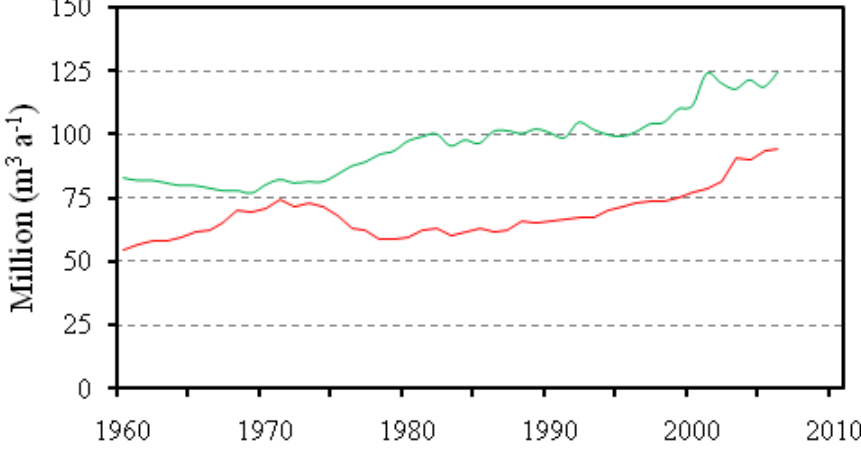
Figure 4. Annual volume increment (green line), and gross harvest (red line) in Swedish forests 1960–2006 (standing volume including bark). Note: All values are five-year averages  85 